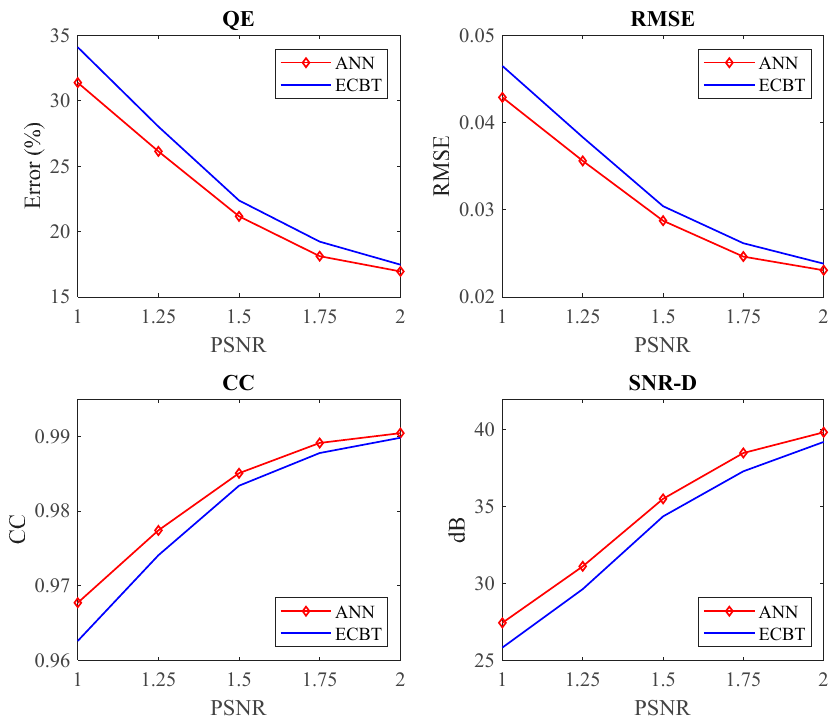
Figure 13. Results of denoising from RF signal in different noise levels where PSNR ranges from 1 to 2 by steps of 0.25, in the case of ‘sharp point’ type.